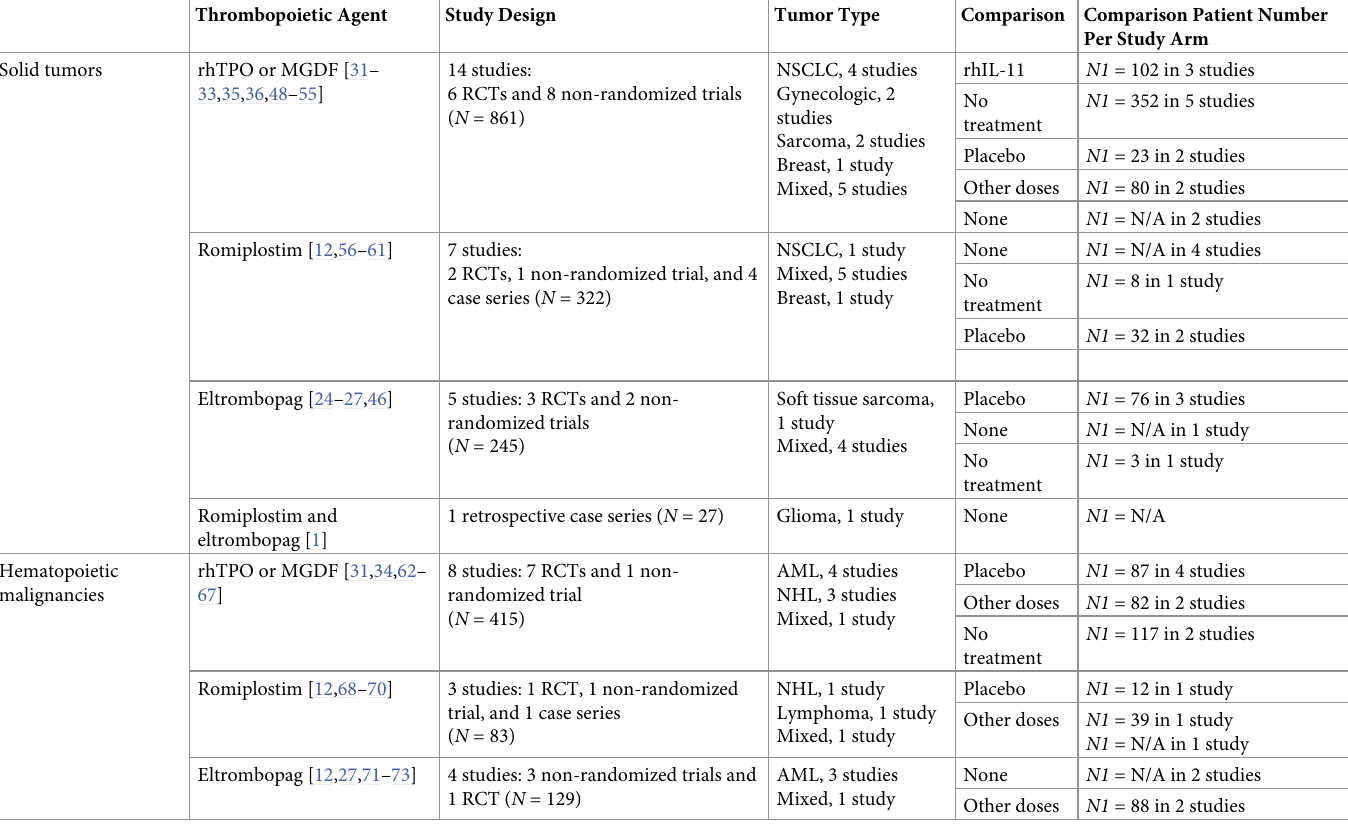
Table 1. Characteristics of studies that met the eligibility criteria for